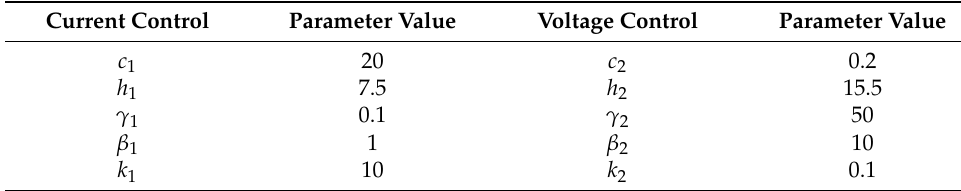
Table 2. The parameters of the adaptive backstepping sliding mode controller.